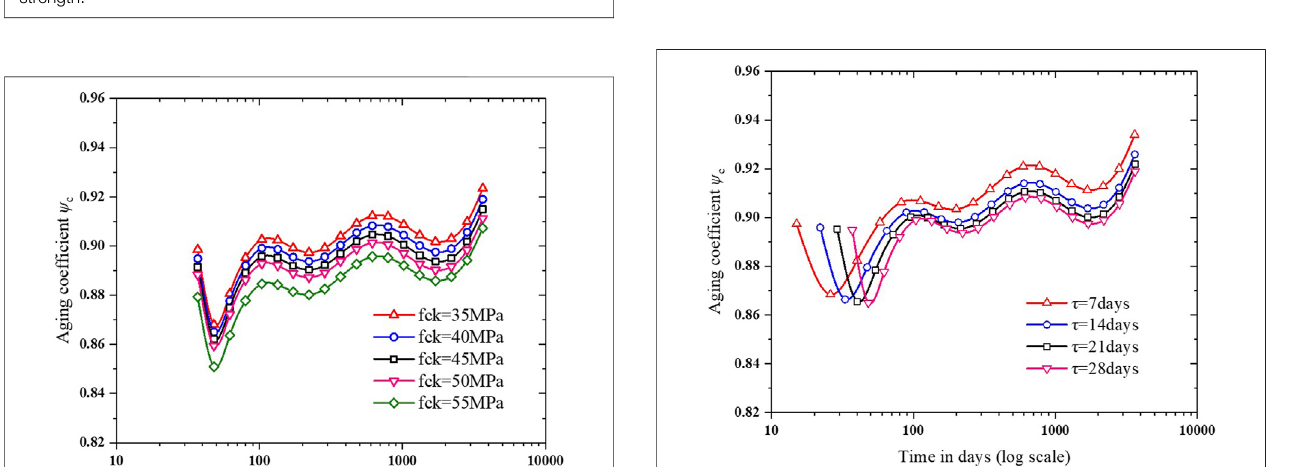
FIGURE 9 | Time dependent relative slip with increasing concrete strength.